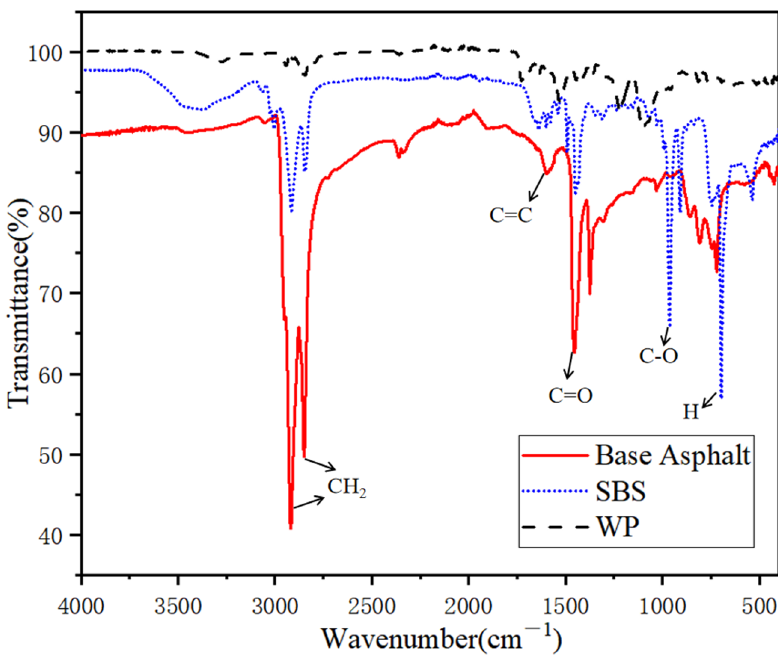
Figure 14. FTIR spectra of SBS and WPU.